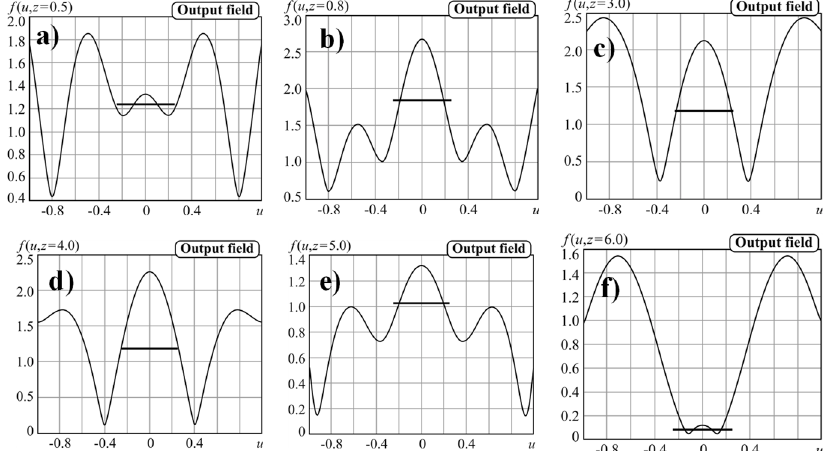
Figure 10. The amplitude of the field of Equation (6) with a = 10, N = 100 and T = 5 λ propagated at the different distances: ( a ) z = 0.5 λ , ( b ) z = 0.8 λ , ( c ) z = 3 λ , ( d ) z = 4 λ , ( e ) z = 5 λ , ( f ) z = 6 λ .